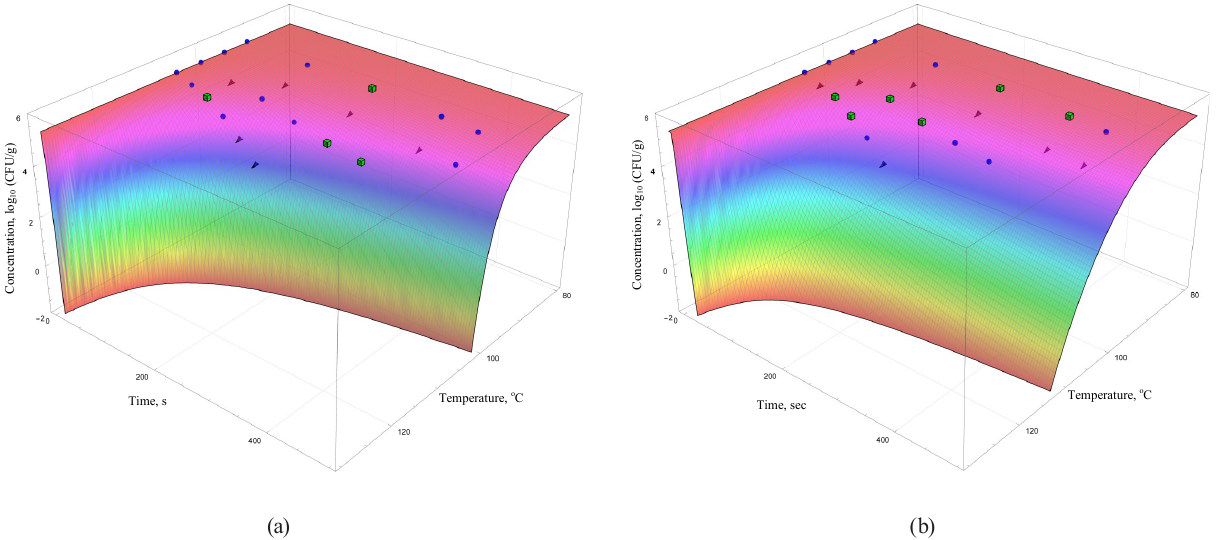
Figure 8 Secondary nonlinear models of microbial death of A. acidoterrestris during heat treatment (a) Membre model,